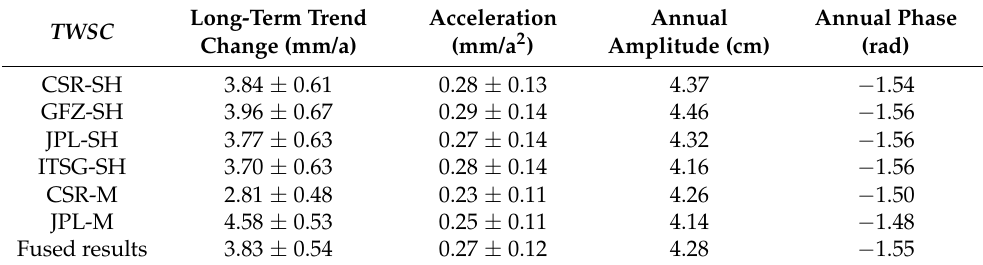
Table 3. The long-term change trend, acceleration, annual amplitude, and annual phase of TWSC from the fused results and the six GRACE solutions in